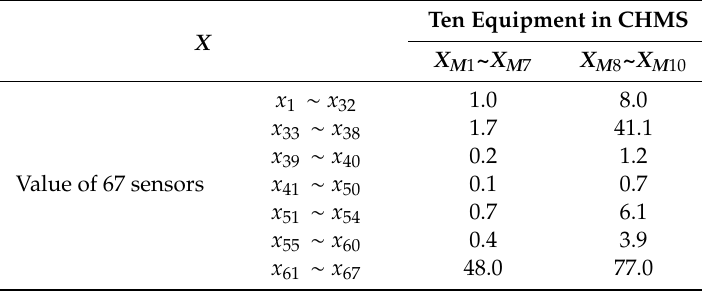
Table 3. Matrix of the input values from sensors to di ff erent equipment in CHMS.